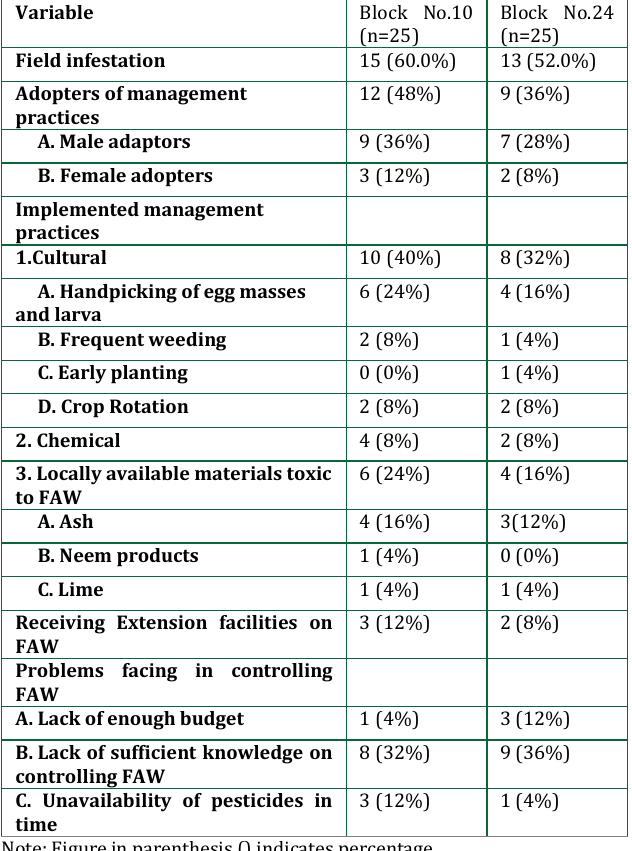
Table 2: Farmer’s knowledge and perception on FAW